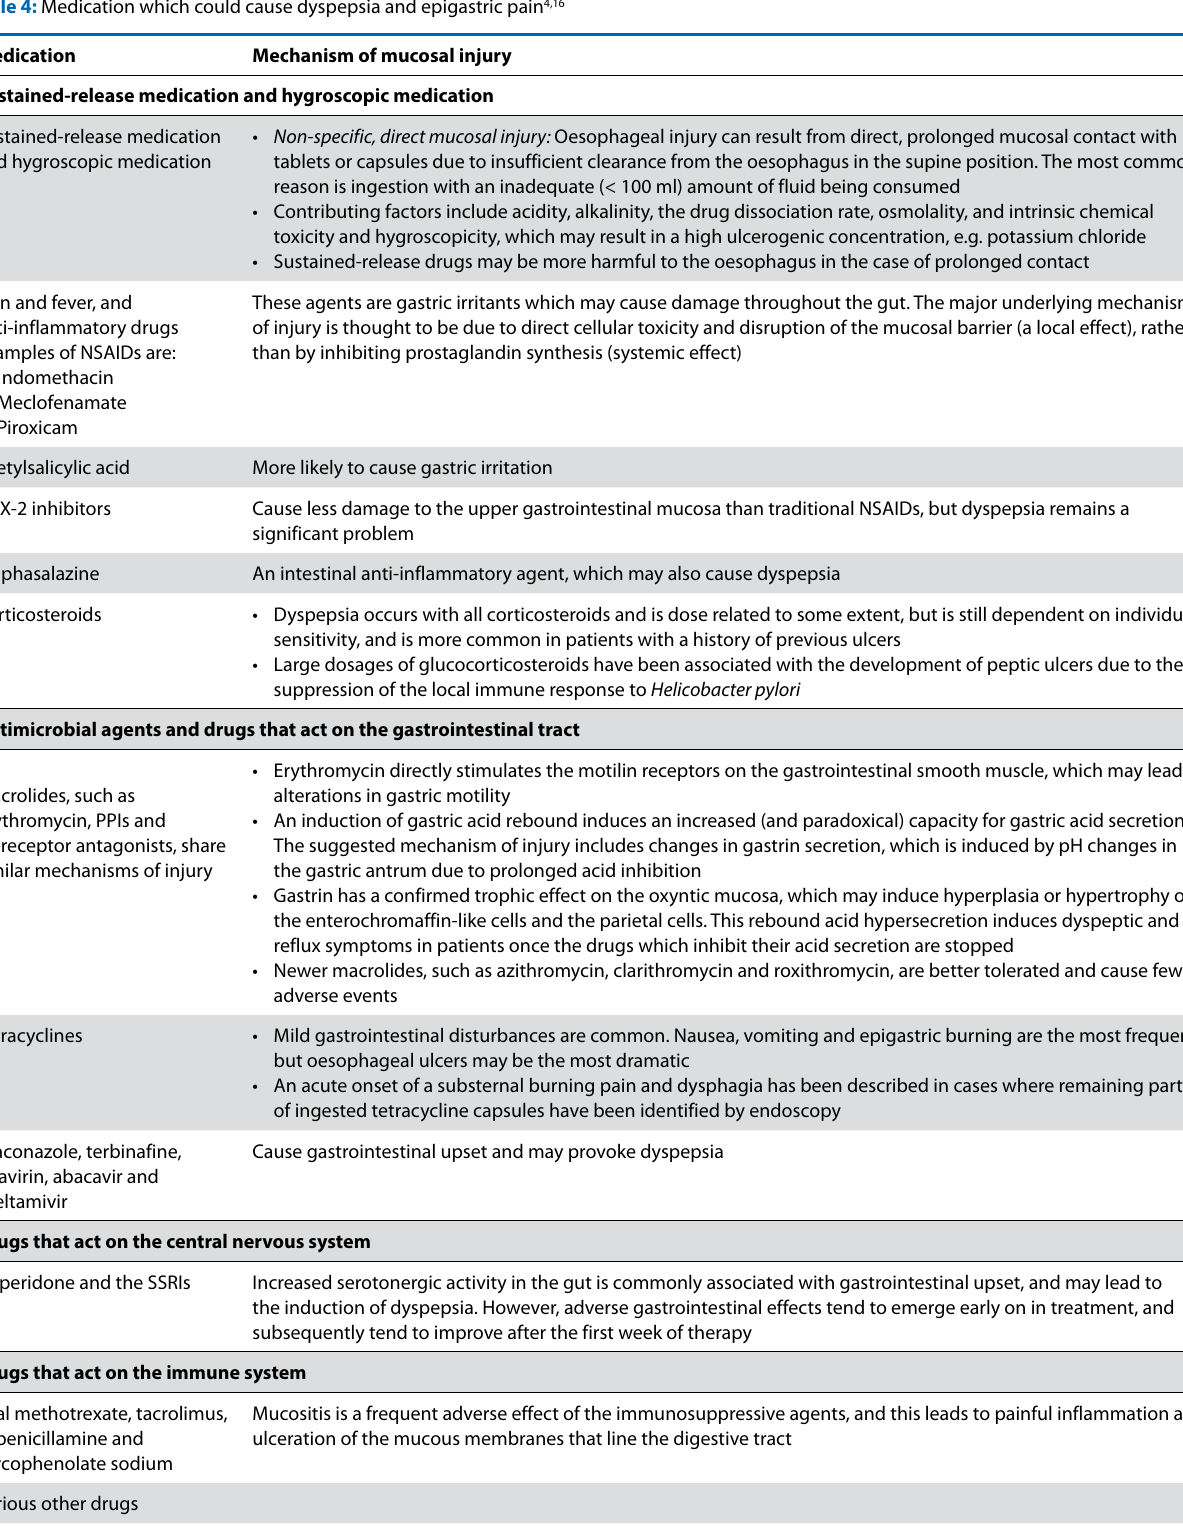
Table 4: Medication which could cause dyspepsia and epigastric pain 4,16